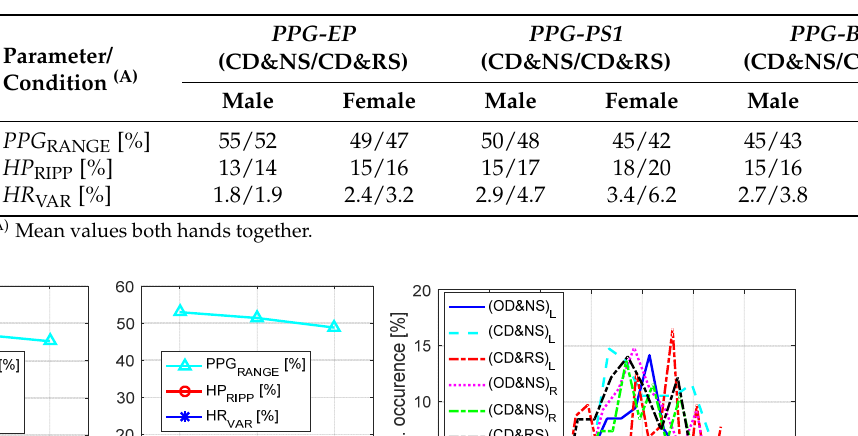
Table 6. PPG signal properties and mean HR parameters for two measurement conditions inside the MRI device for groups of male and female tested persons separately.